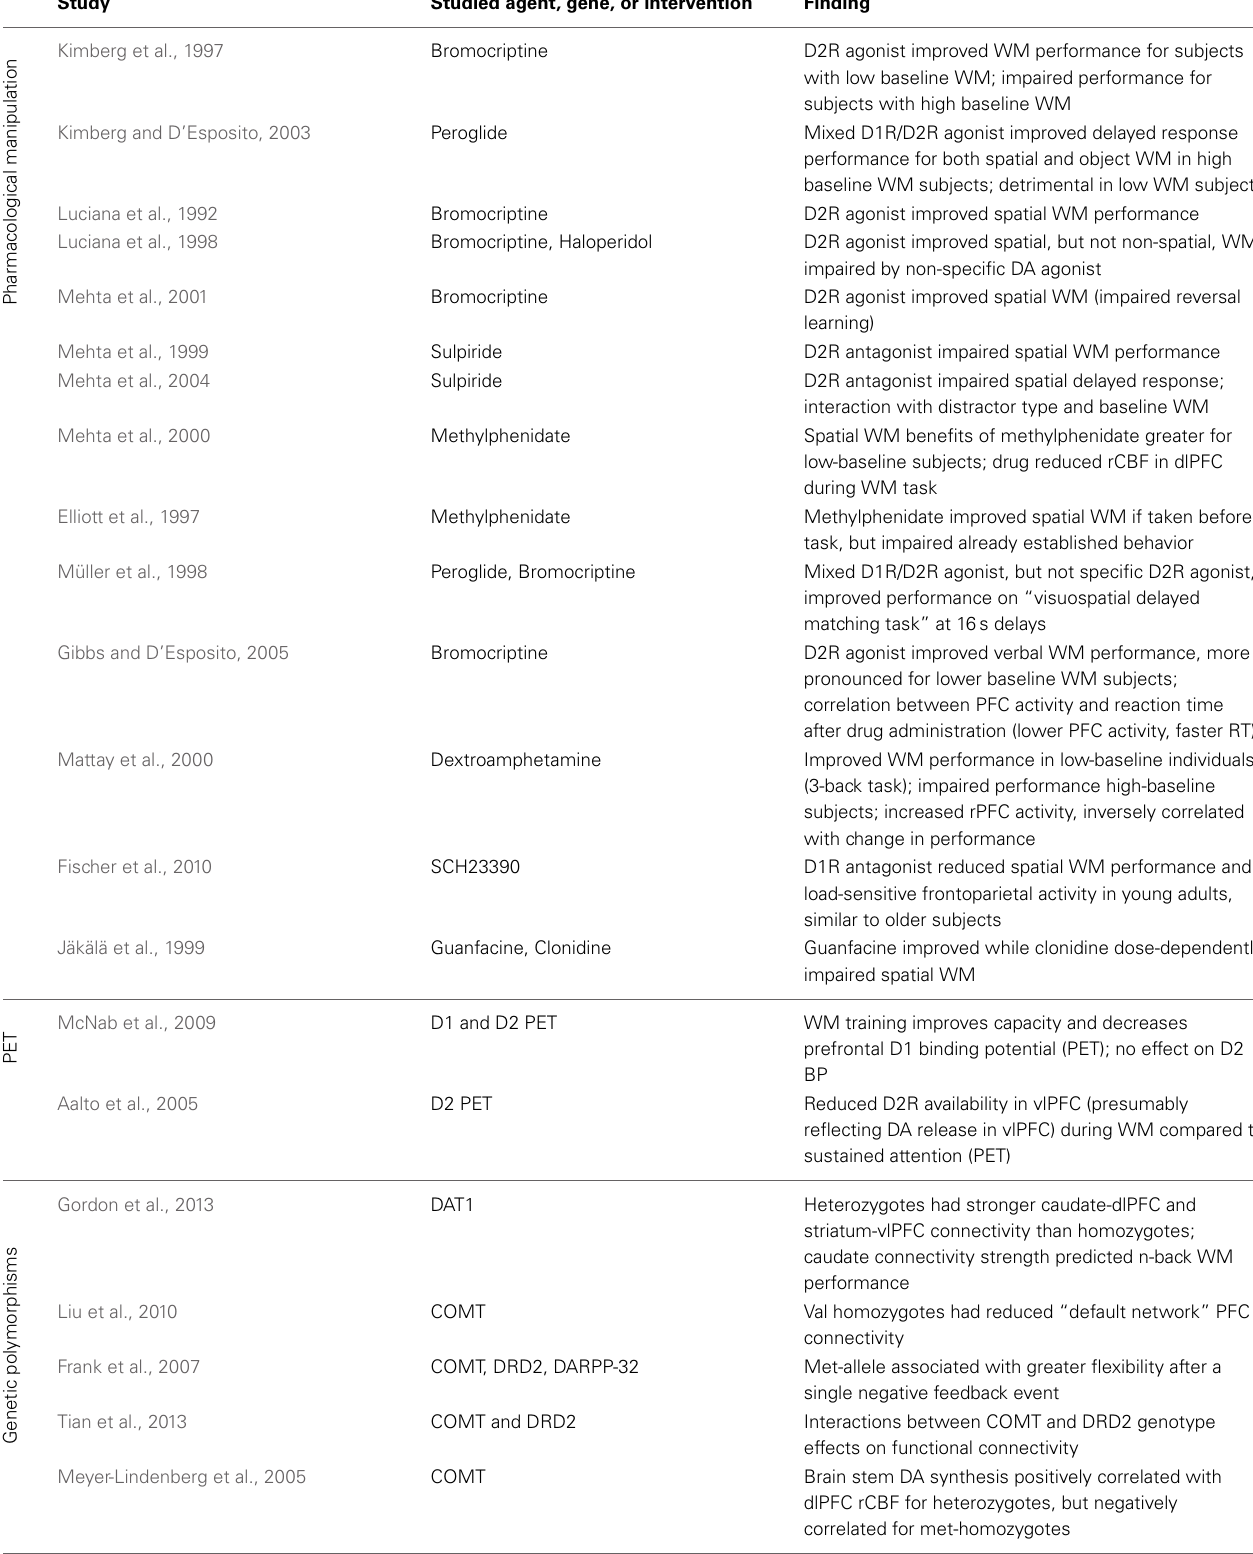
Table 2 | Studies examining the contribution of prefrontal catecholamines to the behavioral and neural correlates of working memory in human